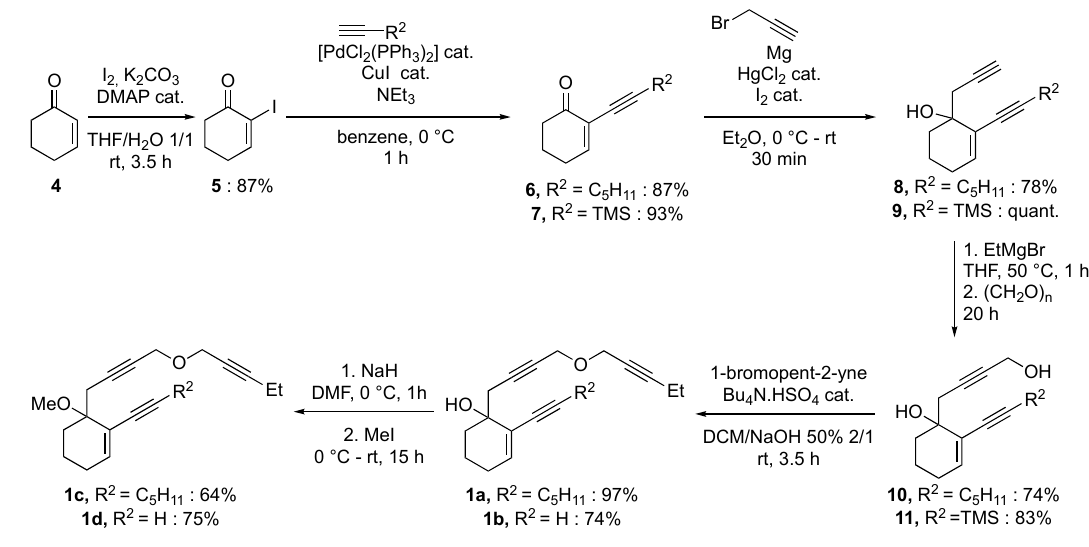
Table 1. Use of Mo(CO) 6 as CO source for the [2+2+2+1] carbonylative cycloaddition and competing pathways of triyne 1a